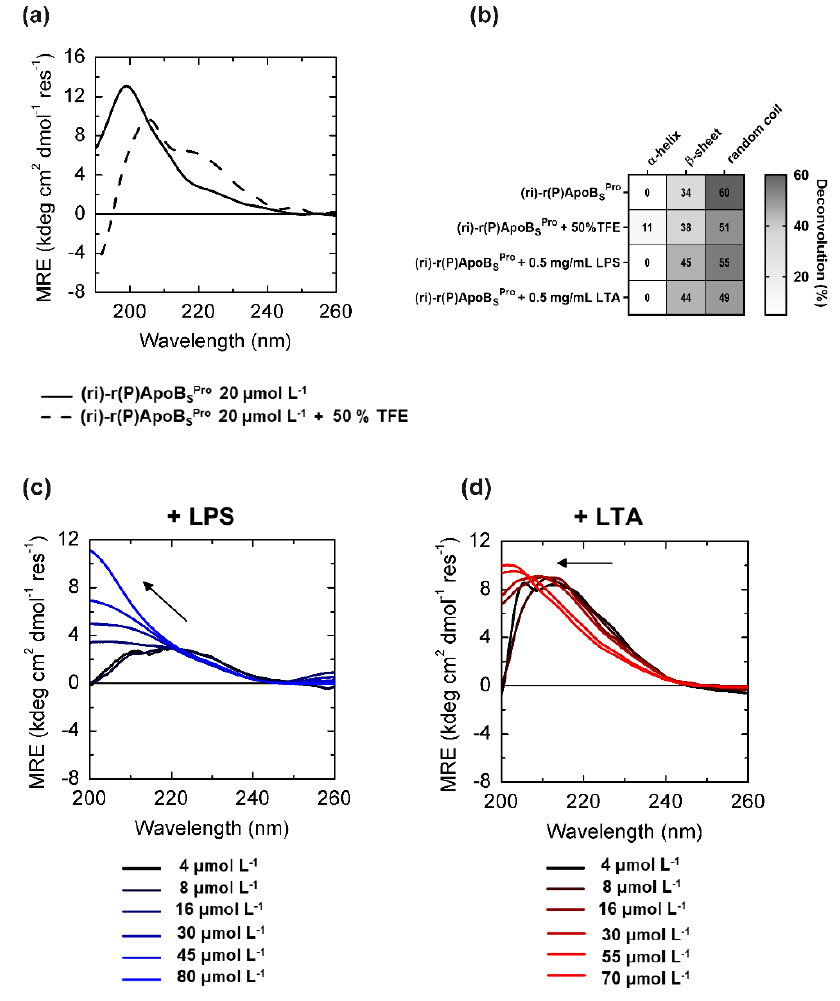
Figure 2. Conformational analyses of (ri)-r(P)ApoB SPro peptide by far-UV circular dichroism. ( a ) CD spectra of peptidomimetic (ri)-r(P)ApoB SPro 20 µmol L − 1 in the absence (black line) or in the presence (black dashed line) of 50% ( v/v ) TFE. ( b ) CD spectra deconvolution percentages of (ri)-r(P)ApoB SPro peptide in 2.5 mM sodium phosphate pH 7.4 buffer and in the presence of 50% TFE, 0.5 mg mL − 1 LPS or LTA. Secondary structure percentages were calculated using CDPRO software. CD spectra at different concentrations of (ri)-r(P)ApoB SPro in the presence of constant amounts (0.2 mg mL − 1 ) of either LPS ( c ) or LTA ( d ).